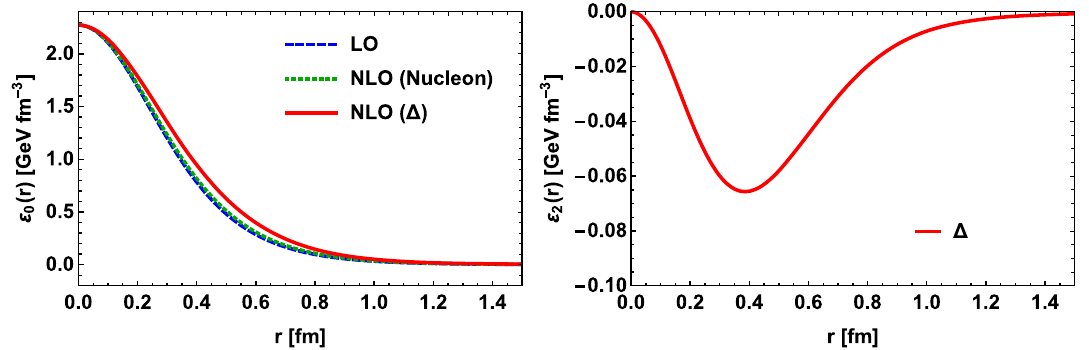
density of the (cid:2) as a function of radius r . The dashed, dotted and solid curves draw the classical soliton, the nucleon and the (cid:2) , respectively